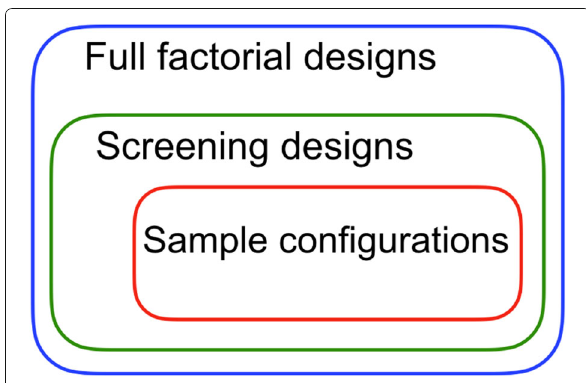
Fig. 4 Configuration subsets—full-factorial design set, screening design set, and sample configuration set